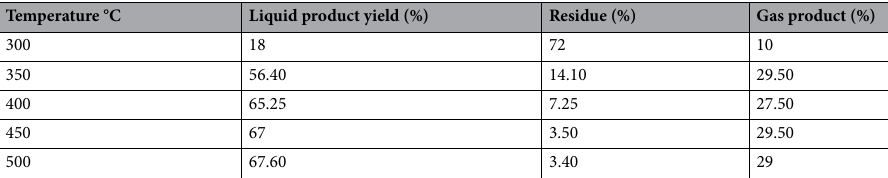
Table 4. Results of temperature effect on thermo catalytic cracking process*. WCO Feed = 100 g, Reaction Time = 15 min, Catalyst Load = 2.5 g, Initial Pressure of Nitrogen = 5